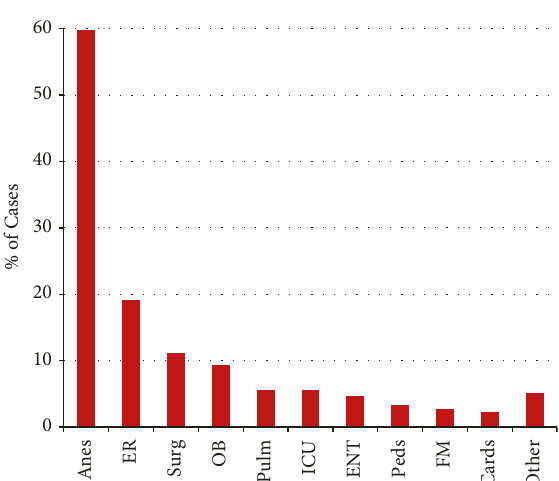
Figure 2: Outcome and mean payments. Standard error bars represent standard error of